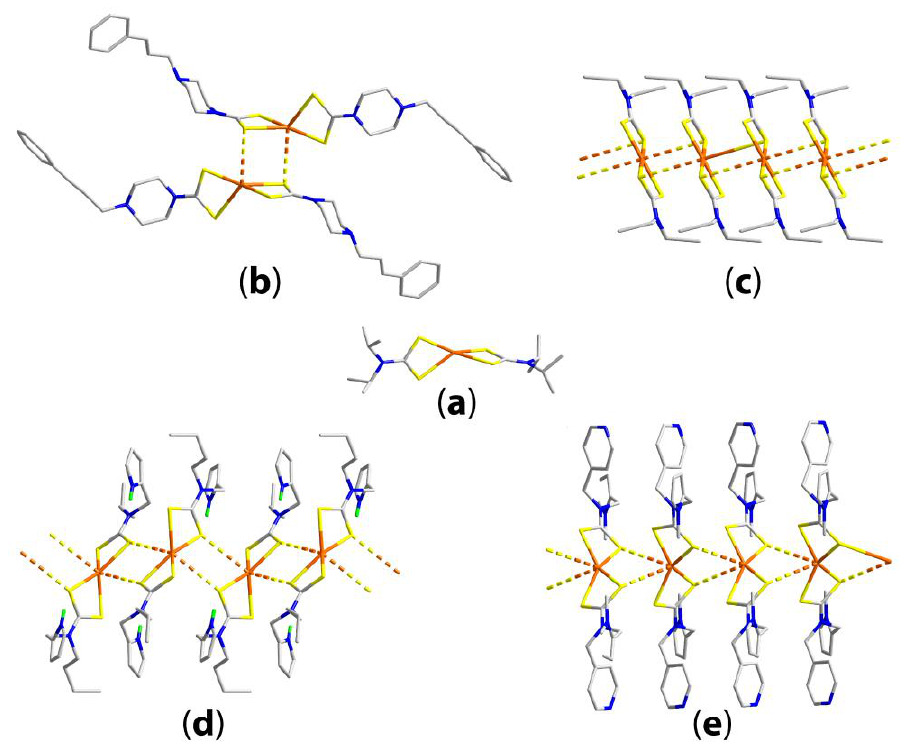
Figure 14. ( a ) Molecular structure of monomeric Hg[S 2 CN(i-Pr) 2 ] 2 ( 142 ). Supramolecular association via Hg … S secondary bonding interactions: ( b ) loosely associated dimer in Hg[S 2 CN(CH 2 ) 4 NCH 2 C(H)=C(H)Ph] ( 147 ) (Hg … S = 3.47 Å ); ( c ) linear supramolecular chain in the crystal of Hg(S 2 CNEt 2 ) 2 ( 157 ) (Hg … S = 3.29 Å ); ( d ) twisted chain in Hg[S 2 CN(n-Bu)CH 2 (1H-pyrrol-2-yl)] ( 161 ) (Hg … S = 3.48 and 3.61 Å ); and ( e ) twisted chain in Hg{S 2 CN[CH 2 (4-py)]CH 2 (1H-pyrrol-2-yl)} ( 162 ) (Hg … S = 3.82 Å ). The dashed Hg … S bonds in ( b – e ) represent secondary bonding interactions.